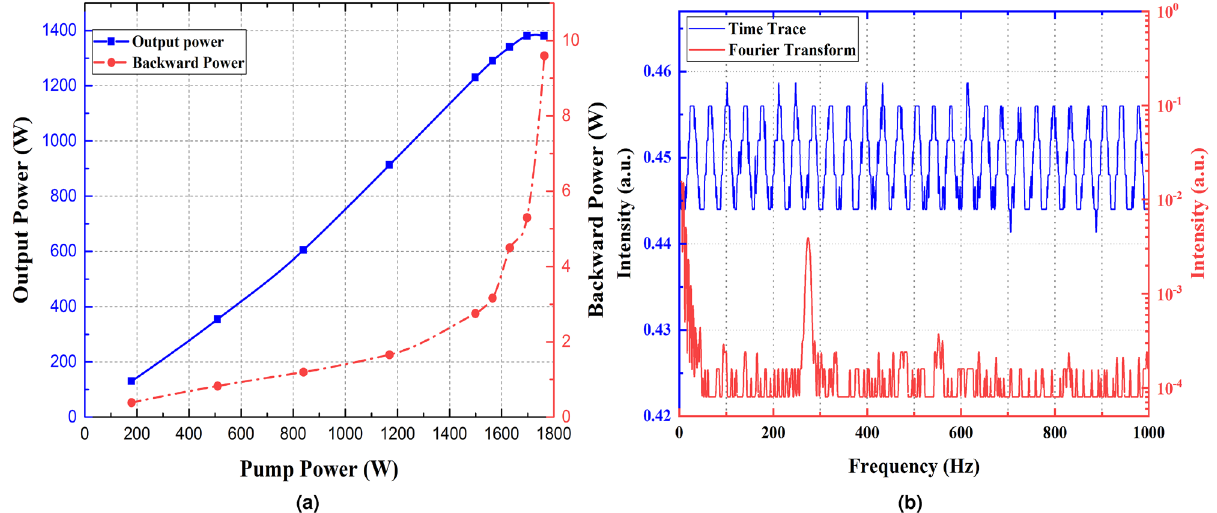
Figure 2. ( a ) The laser output and backward powers versus pumping power in co-pumping configuration. At 1.5 kW pumping power, slope efficiency of the oscillator declines and backward power increases suddenly ( b ) Temporal characteristics of laser output beam at 1.5 kW pumping